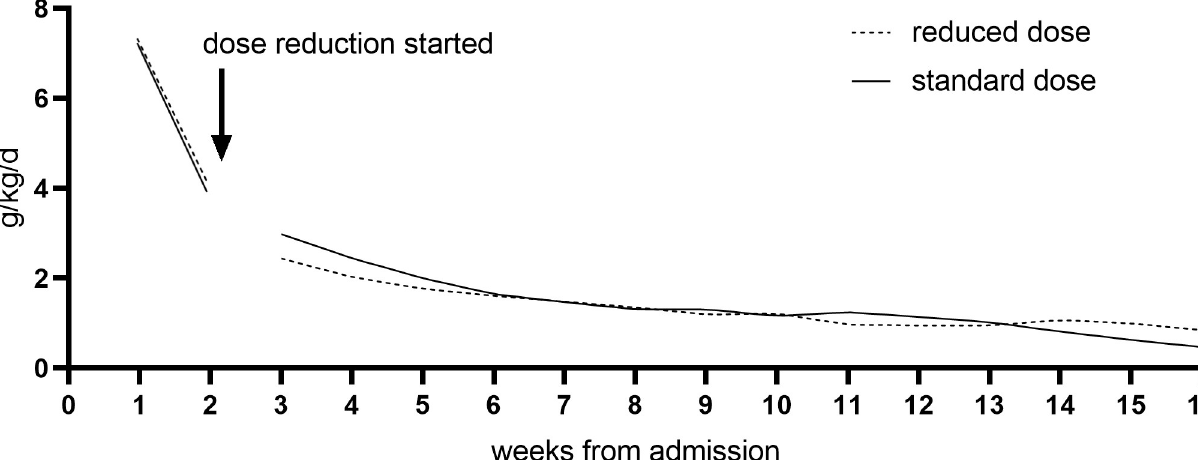
Fig 3. Weekly weight gain velocity (g/kg/day) of children with SAM randomised to reduced or standard RUTF dose, modeled using the mean weight of each group per visit. The first two weeks, when both groups were receiving the standard dose, were plotted apart in order not to mask any effect on weight gain after the reduction came into effect at week 3. A lowess curve was fitted with 224 points calculated between the weeks ranging from 3 to 16. RUTF, ready-to-use therapeutic food; SAM, severe acute malnutrition.